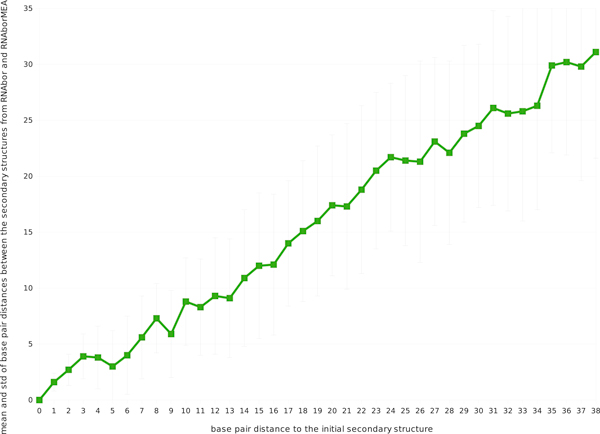
Figure depicting the increasing divergence between RNAborand RNAborMEA. For each RNA sequence in the seed alignment from Rfam family RF00066 of U7 small nuclear RNAs, both RNAbor and RNAborMEA were run, in order to compute the MFE(k) structure and the MEA(k) structure, which have minimum free energy resp. maximum expected accuracy among all k-neighbors of the intial minimum free energy structures S0. We computed the base pair distance between the MFE(k) structure and the MEA(k) structure over all sequences in the seed alignment of RF00066. The figure displays the average ± one standard deviation of base pair distance.